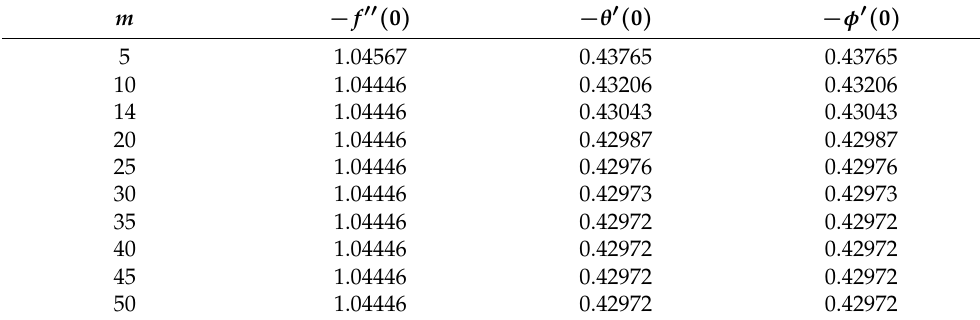
Table 4. The convergence of steady-state approximations of OHAM solutions with β = 0.1, λ 2 =